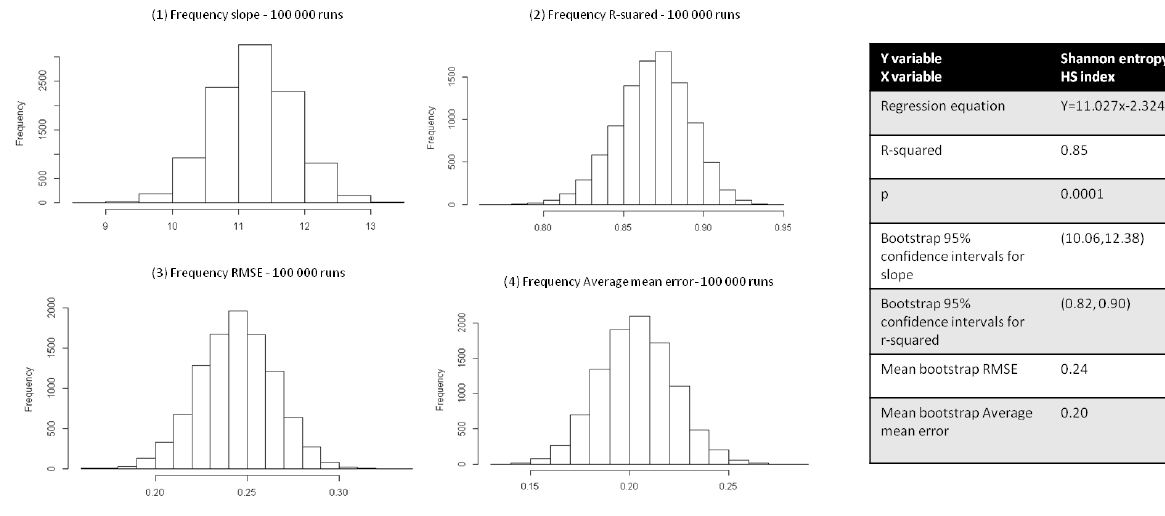
Figure 9. Evaluation of the model robustness between the HS index and the Shannon entropy derived from the TerraSAR-X image using bootstrap sampling method (100,000 runs). ( 1 ) Frequency of slopes; ( 2 ) Frequency of R-squared; ( 3 ) Frequency of RMSE; and ( 4 ) Frequency of Average mean